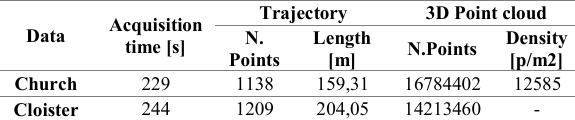
Figure 7. The visible details of the inside of the Church.